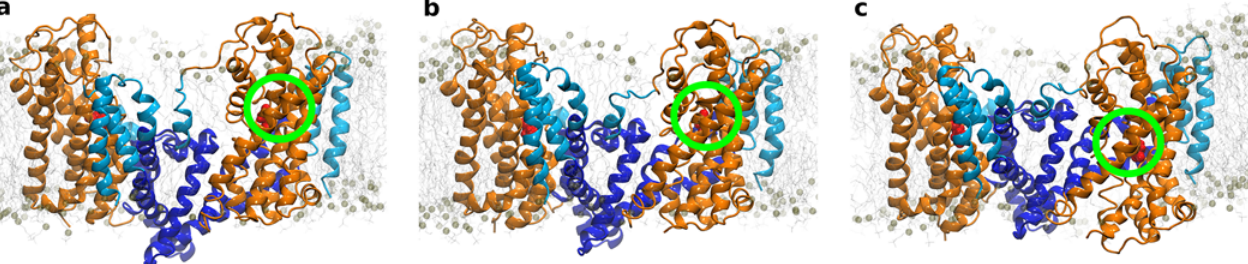
Fig 2. Conformation of GltPh during substrate translocation. Snapshots of the transporter in (a) the outward (at 0 ns), (b) the intermediate (at 152 ns) and (c) the inward-facing state (at 272 ns): the transport domain remained in contact with the membrane and translated minimally relative to the membrane normal, while the trimerzation domain moved towards the cell